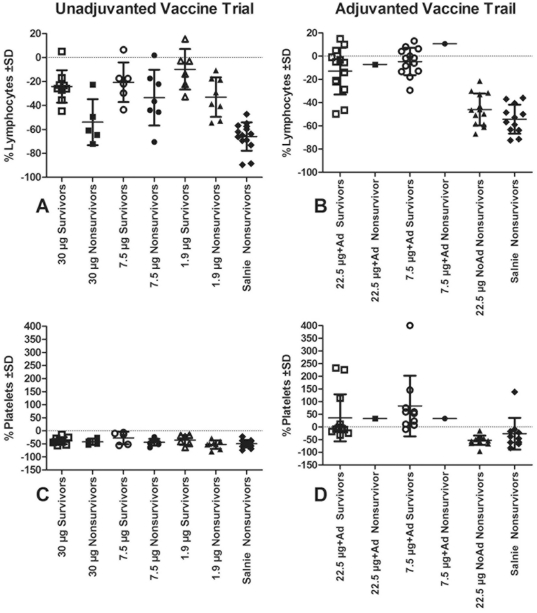
Post-instillation lymphopenia and thrombocytopenia in vaccinated ferrets.Data represent the percentage change from pre-instillation collection and samples available for analysis. Mean change and standard deviation (SD) are represented for each group.